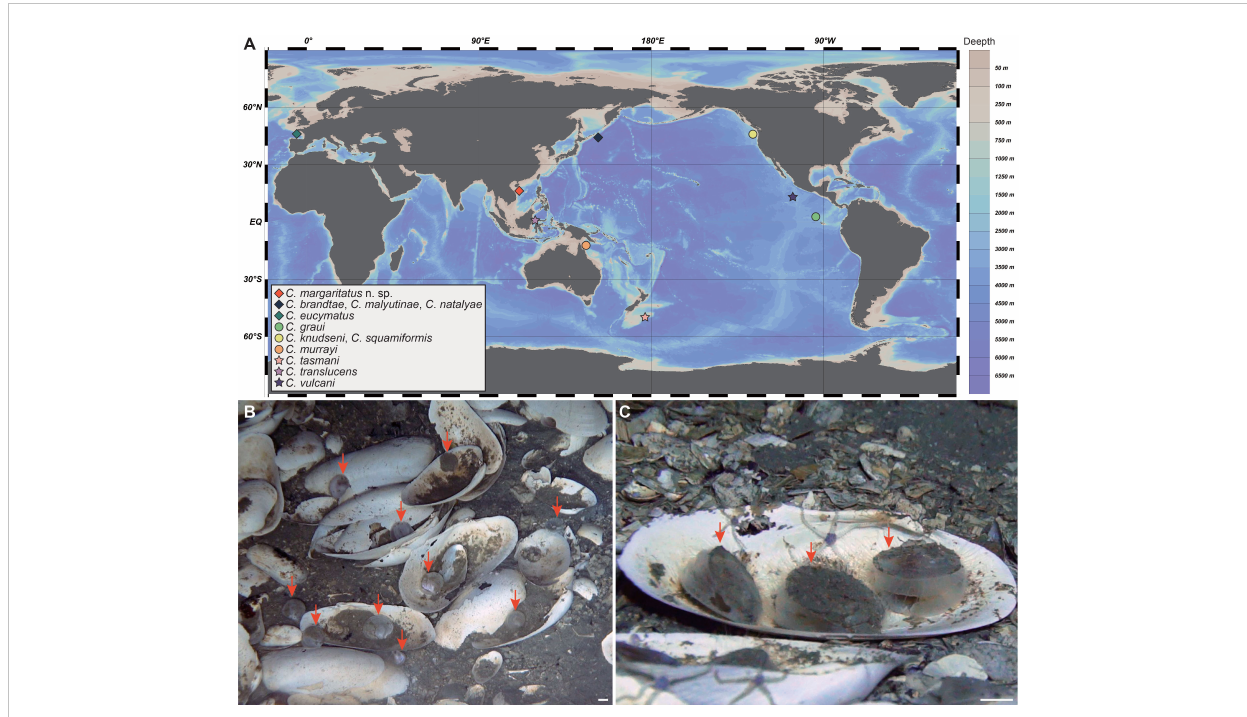
FIGURE 1 Worldwide geographical distribution of species in the genus Catillopecten and the typical habitat of the new species. (A) Locality of the species of Catillopecten , holotypes only. (B, C) Typical habitat of C. margaritatus n. sp. (indicated by red arrows), which were often found on the empty shells of Archivessica marissinica . Scale bar: (B, C) 10